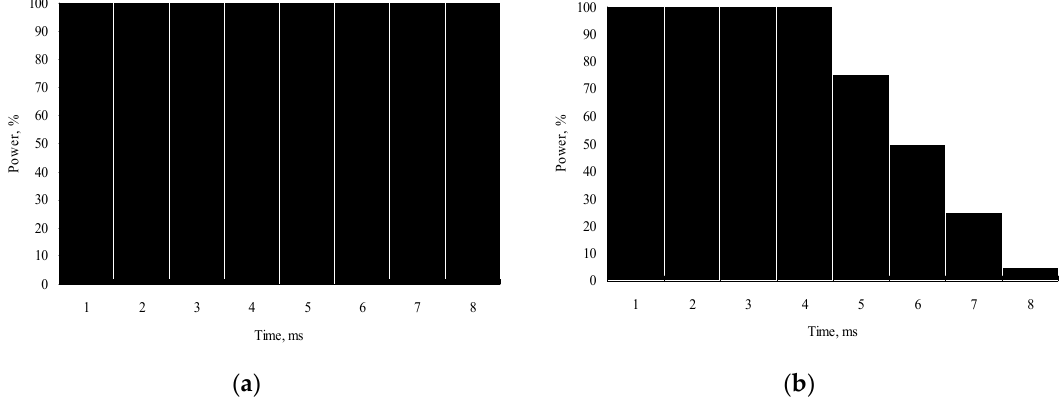
Figure 5. Laser pulse shaping: ( a ) square pulse shaping; and ( b ) ramp-down pulse shaping.